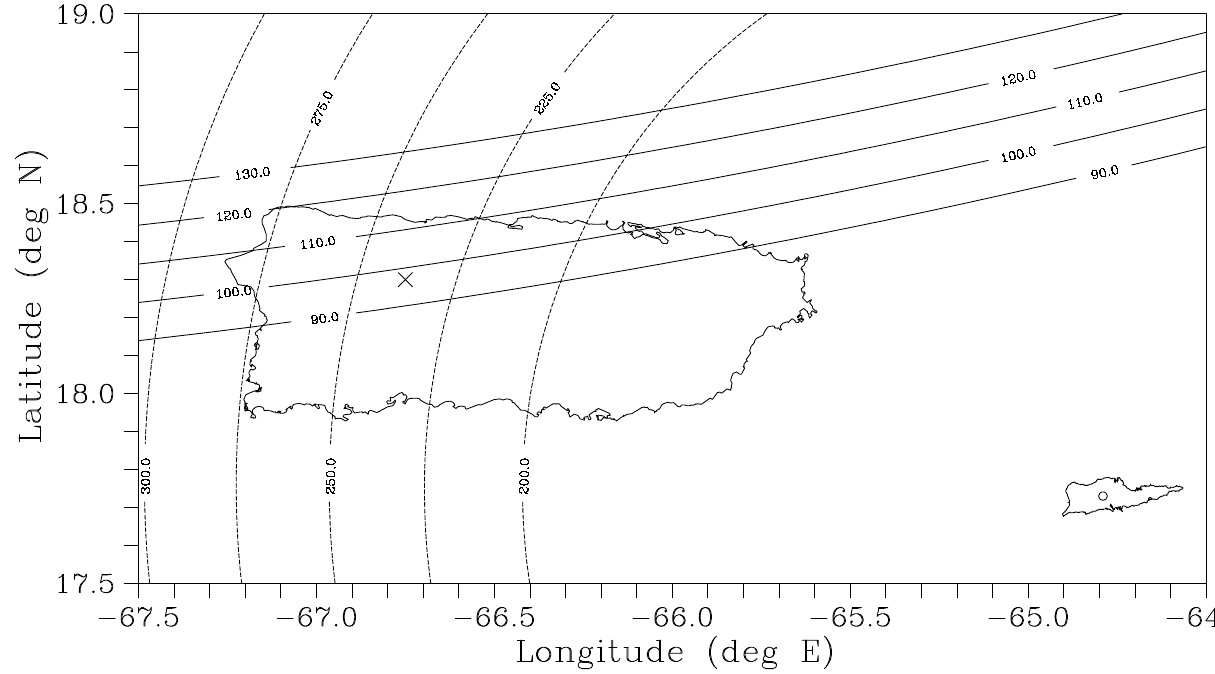
Fig. 1. Map illustrating the geometry of the common-volume radar experiments. An “x” and an “o” mark the locations of the Arecibo and the 30MHz radars, respectively. Concentric dashed circles indicate the distance from the radar on St. Croix to a point on the circle at 100km altitude. Horizontal curves represent the locus of perpendicularity from St. Croix at different